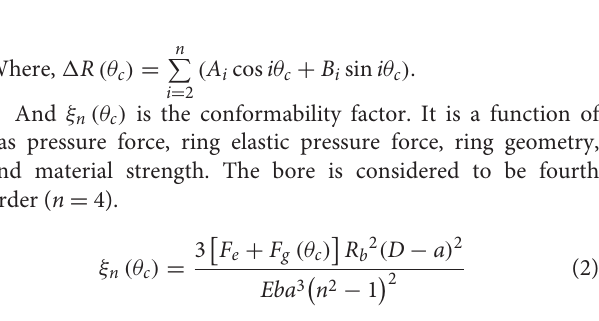
FIGURE 1 | (A) Ring profile geometry. (B) Profile variation due to offset